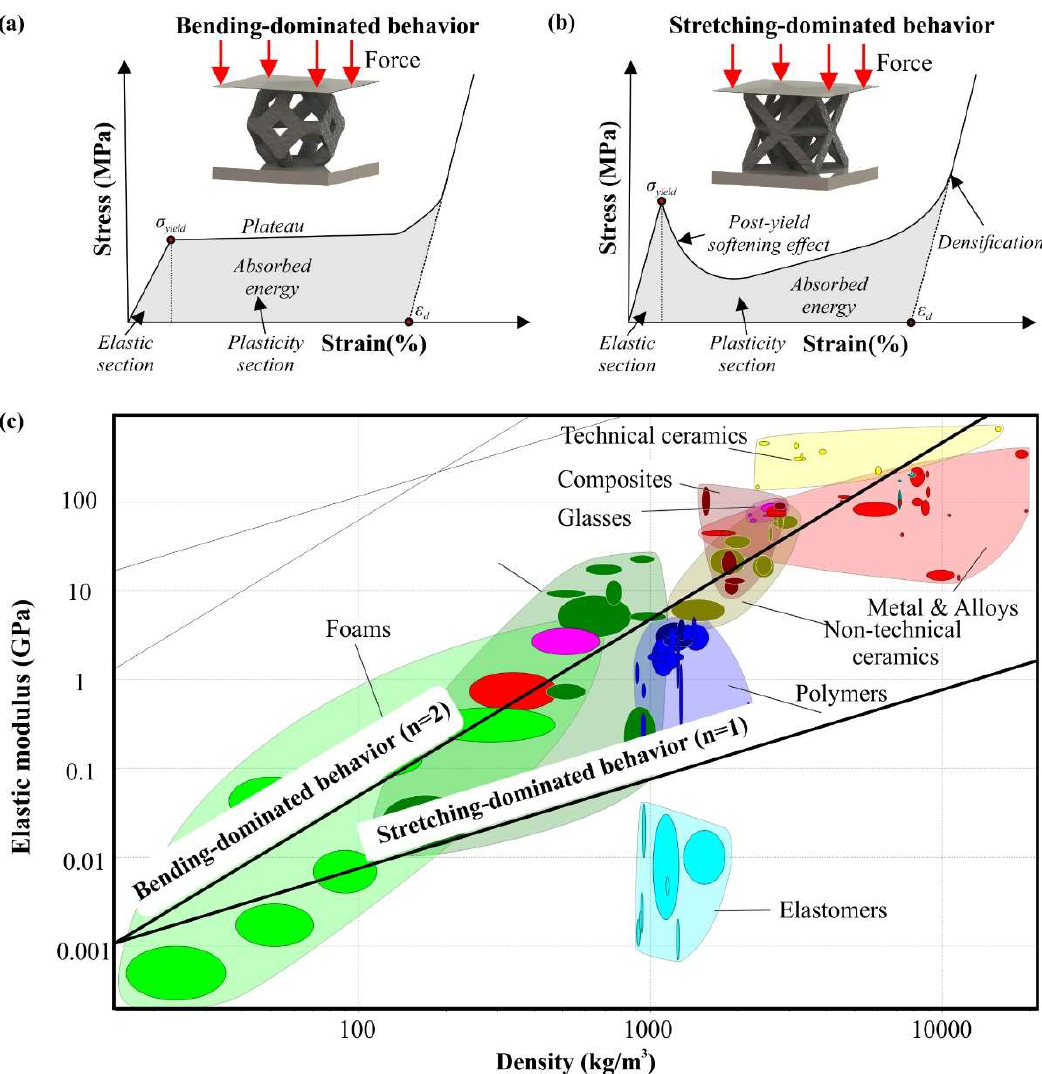
Figure 2. Indicative mechanical response for a structure with: ( a ) stretching-dominated behavior (Octet); ( b ) bending-dominated behavior (Kelvin); ( c ) Material property chart coupled with the curve for the two examined mechanical behaviors.